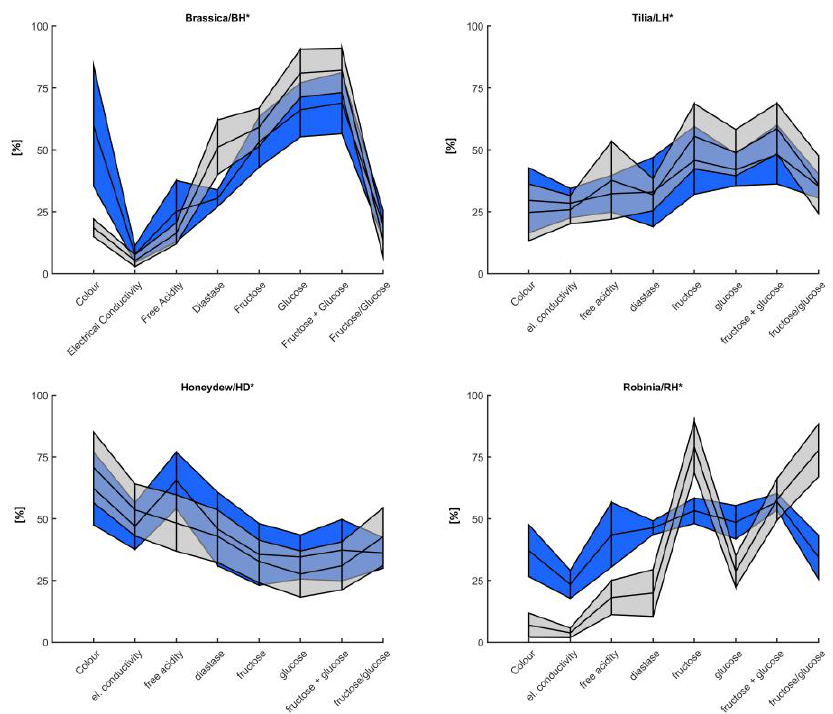
Figure 3. Physico-chemical profiles of the European and Czech honeys. Grey—European honey [9]; blue—Czech honey.